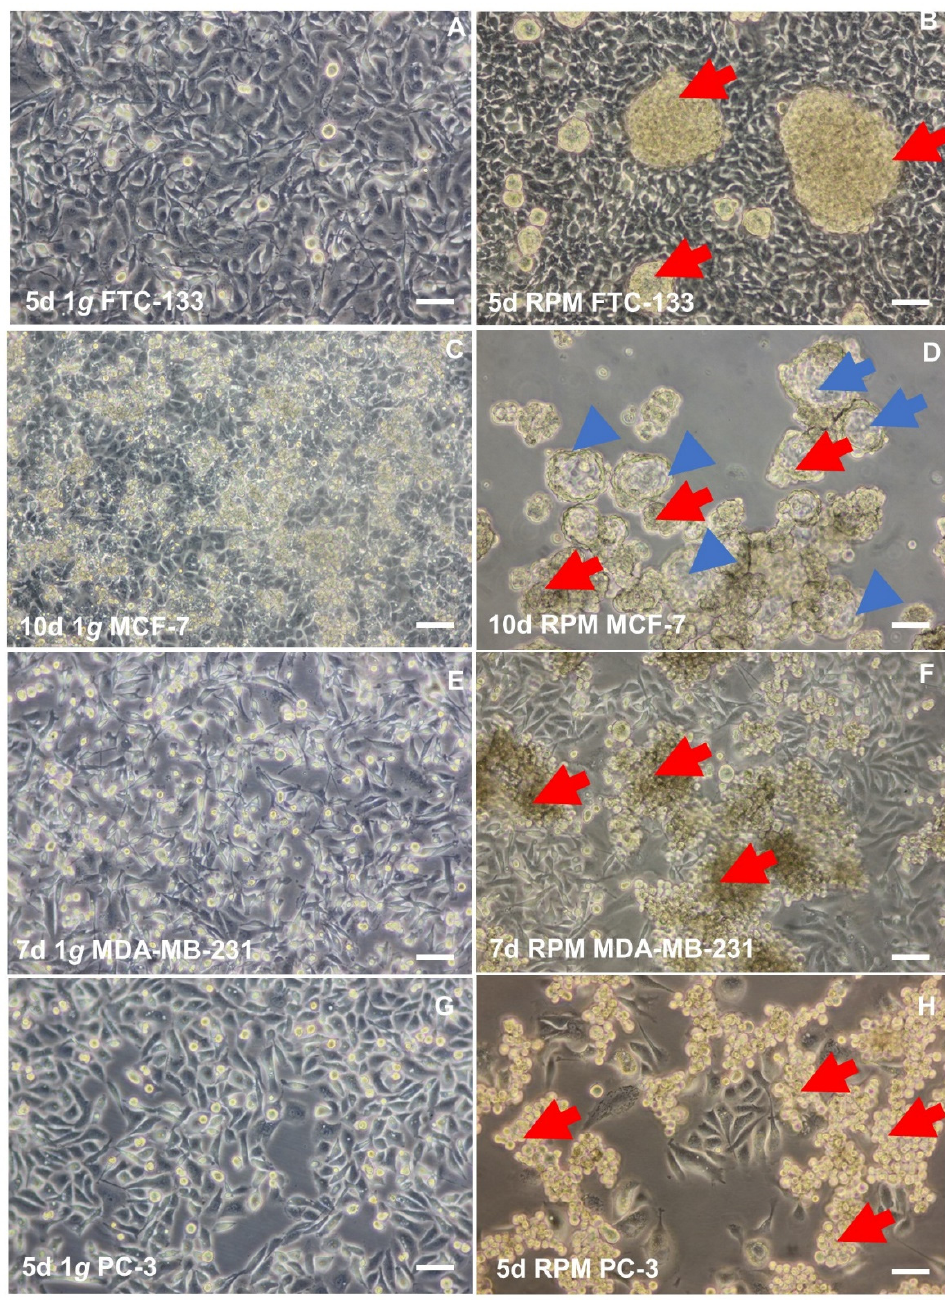
Figure 4. Phase contrast microscopy: ( A ) 5d, 1 g FTC-133 TCC, ( B ) 5d RPM FTC-133 cells, MCS are visible (red arrows); ( C ) confluent and overgrown MCF-7 BC cells after 10 d at static 1 g conditions, ( D ) 10-d RPM-exposure of MCF-7 revealed compact MCS (red arrows), but also glandular structures (blue arrows); ( E ) 7 d, 1 g MDA-MB-231 BCC, ( F ) 7-d exposure of MDA-MB-231 triple negative BCC revealed 3D MCS; ( G ) 5 d, 1 g PC-3 PCC and ( H ) compact 5 d MCS of PC-3 cells on the RPM (red arrows); magnification ×100.; scale bars: 50 µm Compared to 1 g -MCS, which were generated using, among others, ‘hanging drop,’ ‘liquid overlay,’ or the ‘spinner flask’ technique, MCS generated under µ g were